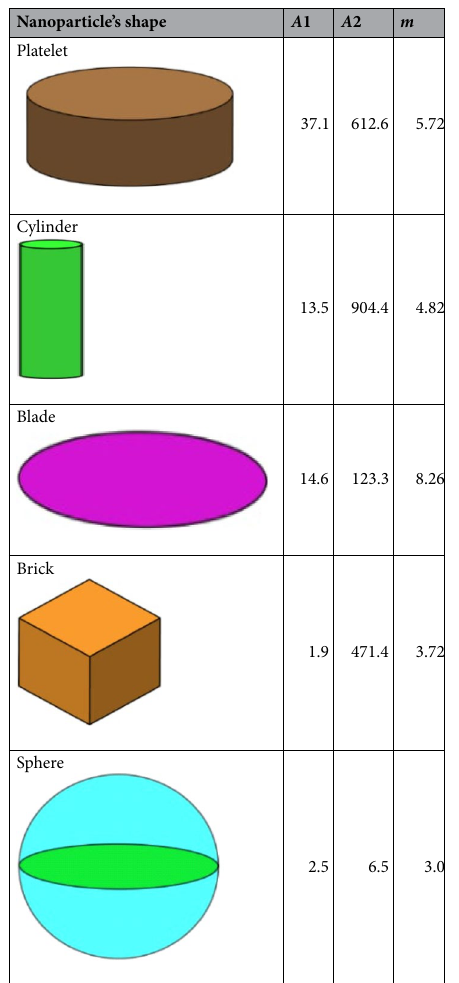
Table 2. Heat capacitance coefficients, size, and nanoparticle’s shapes 14